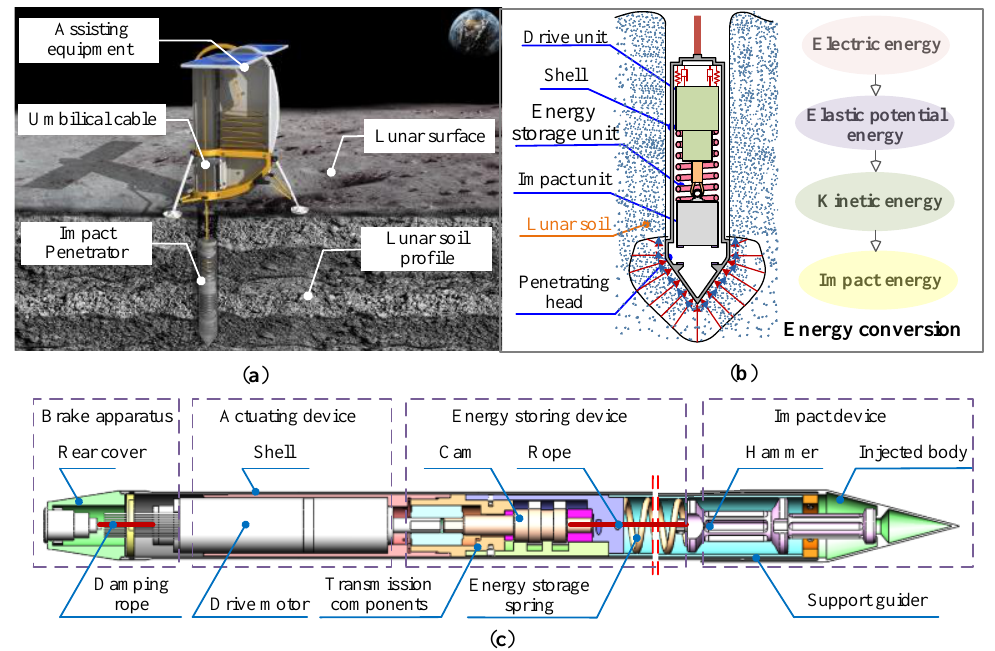
Figure 1. Scheme of impact penetrating detection system: ( a ) a schematic diagram of the working scenario; ( b ) schematic diagram of working principle and energy conversion process; ( c ) the three- dimensional diagram of cam-cable-driven mechanism energy-storing type penetrator prototype.